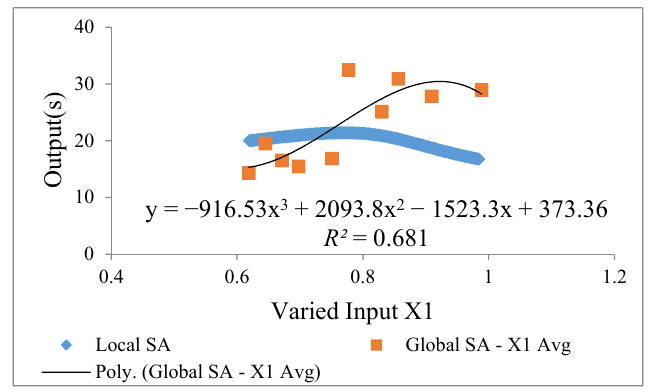
Figure 10. Network output (CL) for varied relative compactness (X1).